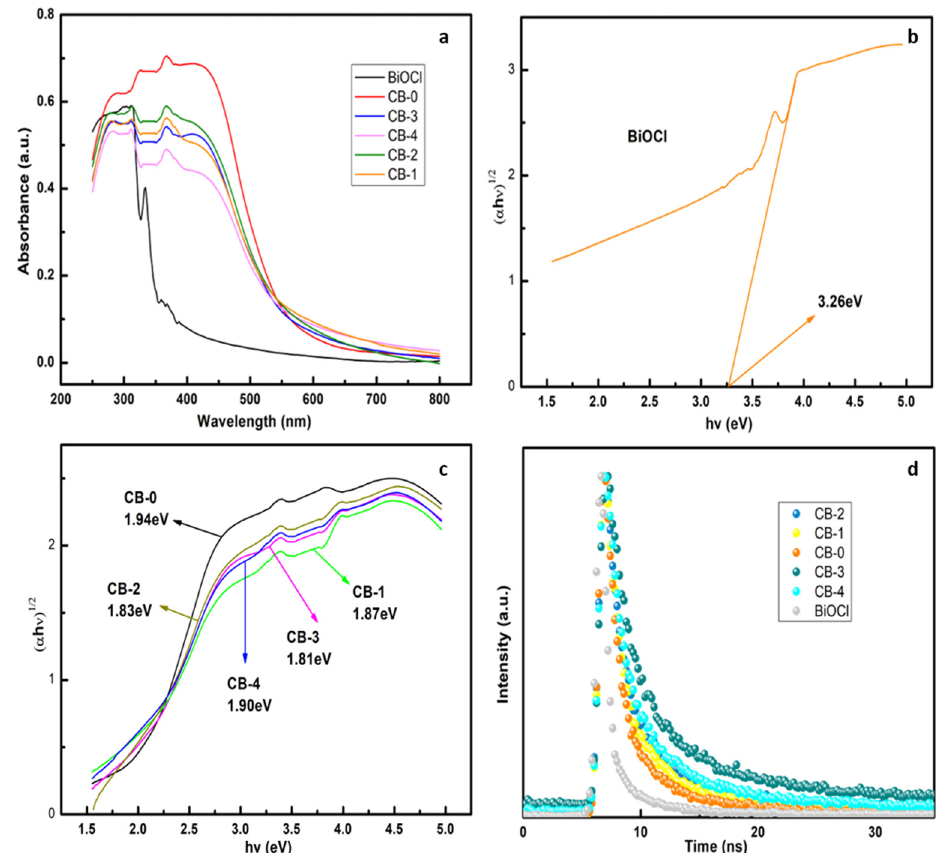
Figure 7. ( a ) UV-vis DRS, ( b , c ) Tauc plots, and ( d ) time-resolved